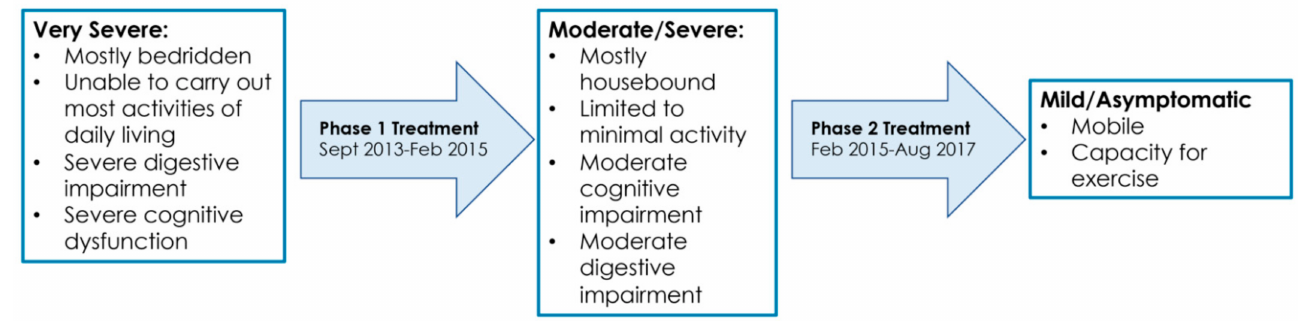
Figure 2. Symptom timeline over the course of treatment for ME/CFS (September 2013–August